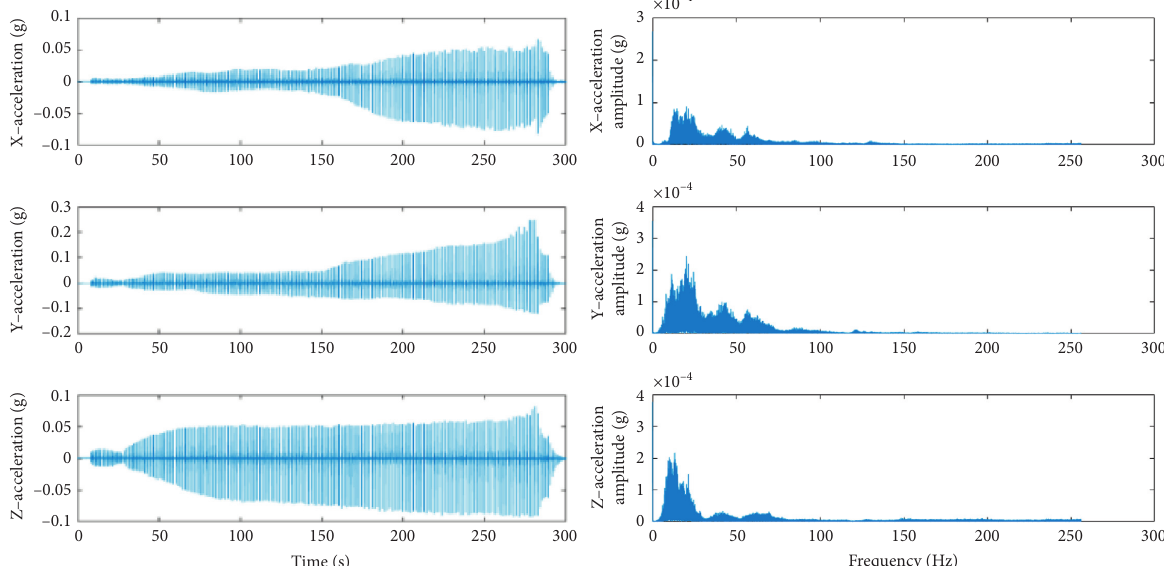
Figure 4: Acceleration time-history curve and amplitude spectrum.